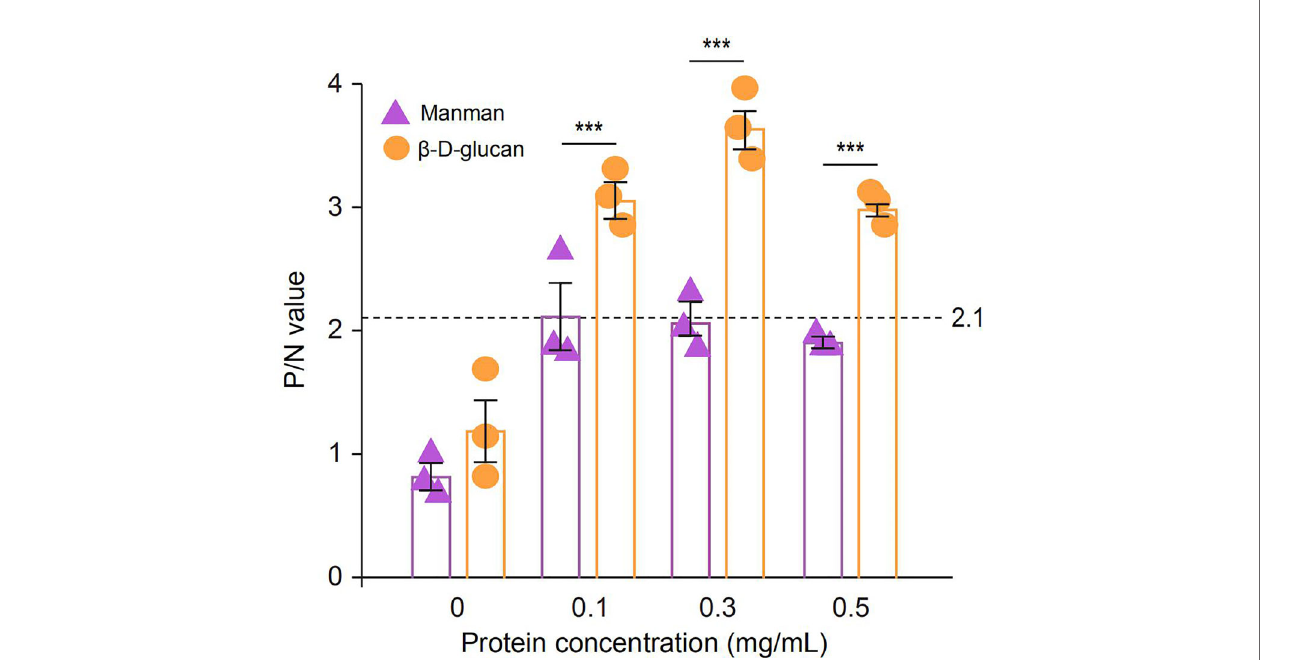
FIGURE 6 | ELISA analysis of the interaction between recombinant SPINK7 and fungal PAMPs. Plates were coated with two fungal PAMPs ( b -D-glucan and mannan), and then incubated with SPINK7 at 25°C for 3h. After stopping the TMB color reaction, the plates were read at OD 450 using a microplate reader. The negative control is unimmunized serum, and empty wells were used as blanks. Samples with (P sample - B blank)/ (N negative - B blank ) > 2.1 were considered positive. Student ’ s t-test: ***P < 0.001. Bars indicate standard error of the mean (n = 3).